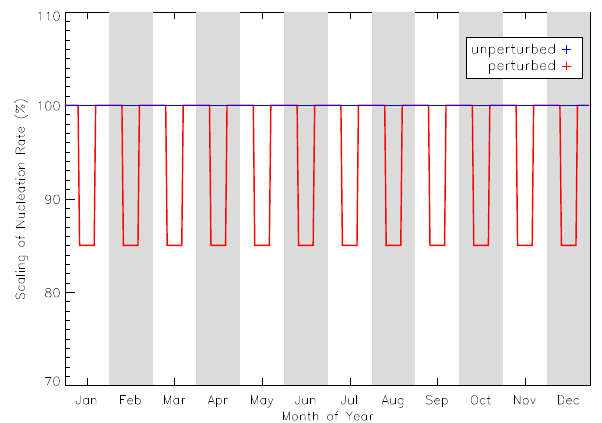
Fig. 1. Schematic of how the nucleation rate is scaled throughout the year. In the perturbed simulations (red), the nucleation rate was scaled to 85% of its calculated value for the middle ten days of each